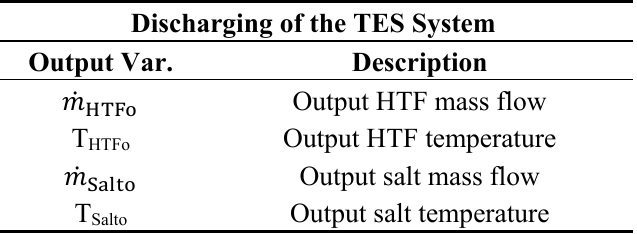
Table 10. Heat exchanger output